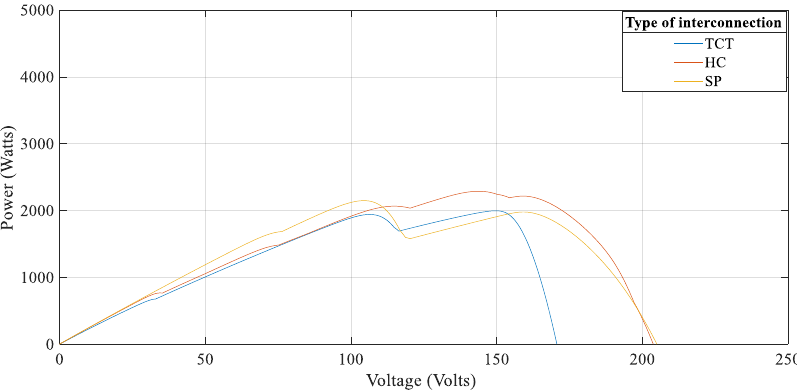
Figure 13. P-V curve for multiple faults ‘F4′ (monocrystalline PV).